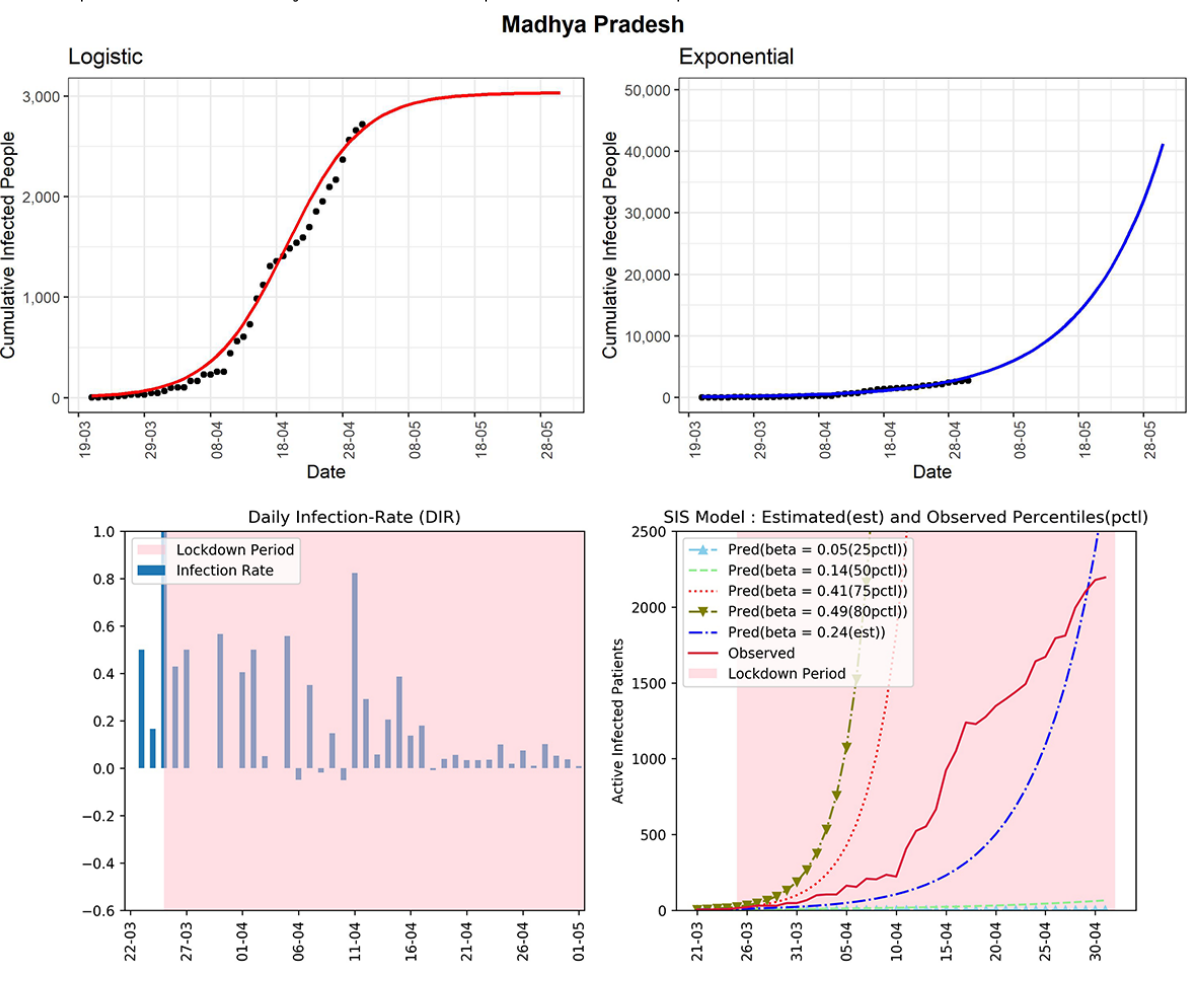
Figure 7. Graphs for the state of Madhya Pradesh. SIS: susceptible-infectious-susceptible.